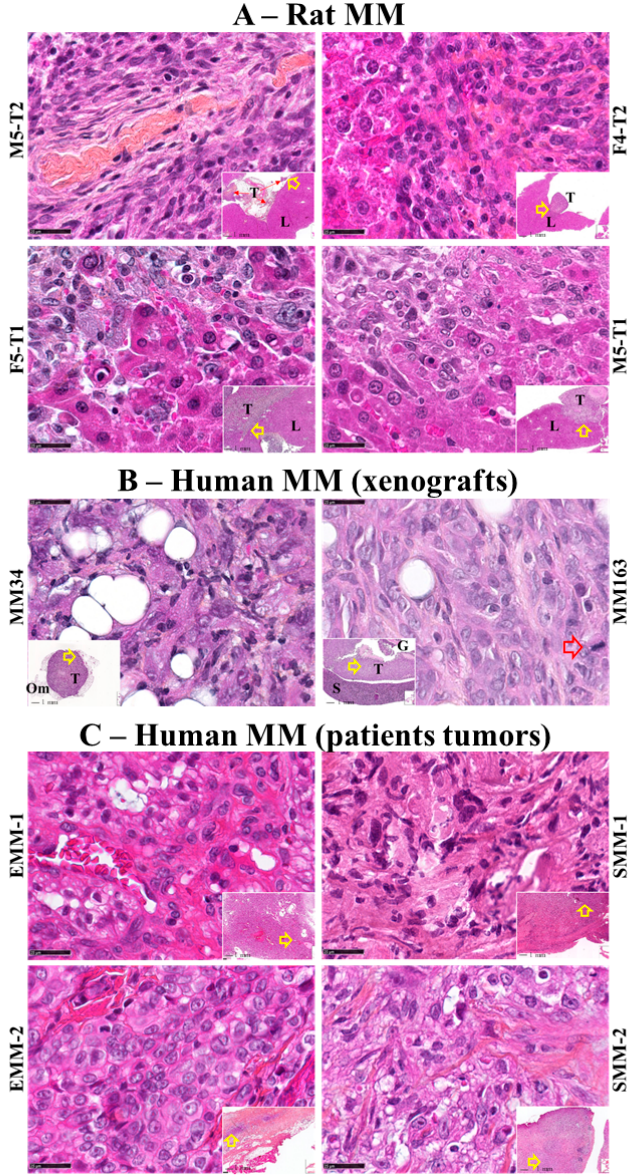
Figure 1. Histological features of the three sources of malignant mesothelioma MM tumors. High magnification views, hematoxylin-phloxine-saffron (HPS) staining (×800, scale bars represent 25 µm), and general views in inserts (×25, scale bars represent 1 mm) with open red arrows indicating the location of magnifications. ( A ) Rat MM tumors of the four experimental models (the names of the corresponding cell lines are indicated on the external side of the photographs). These